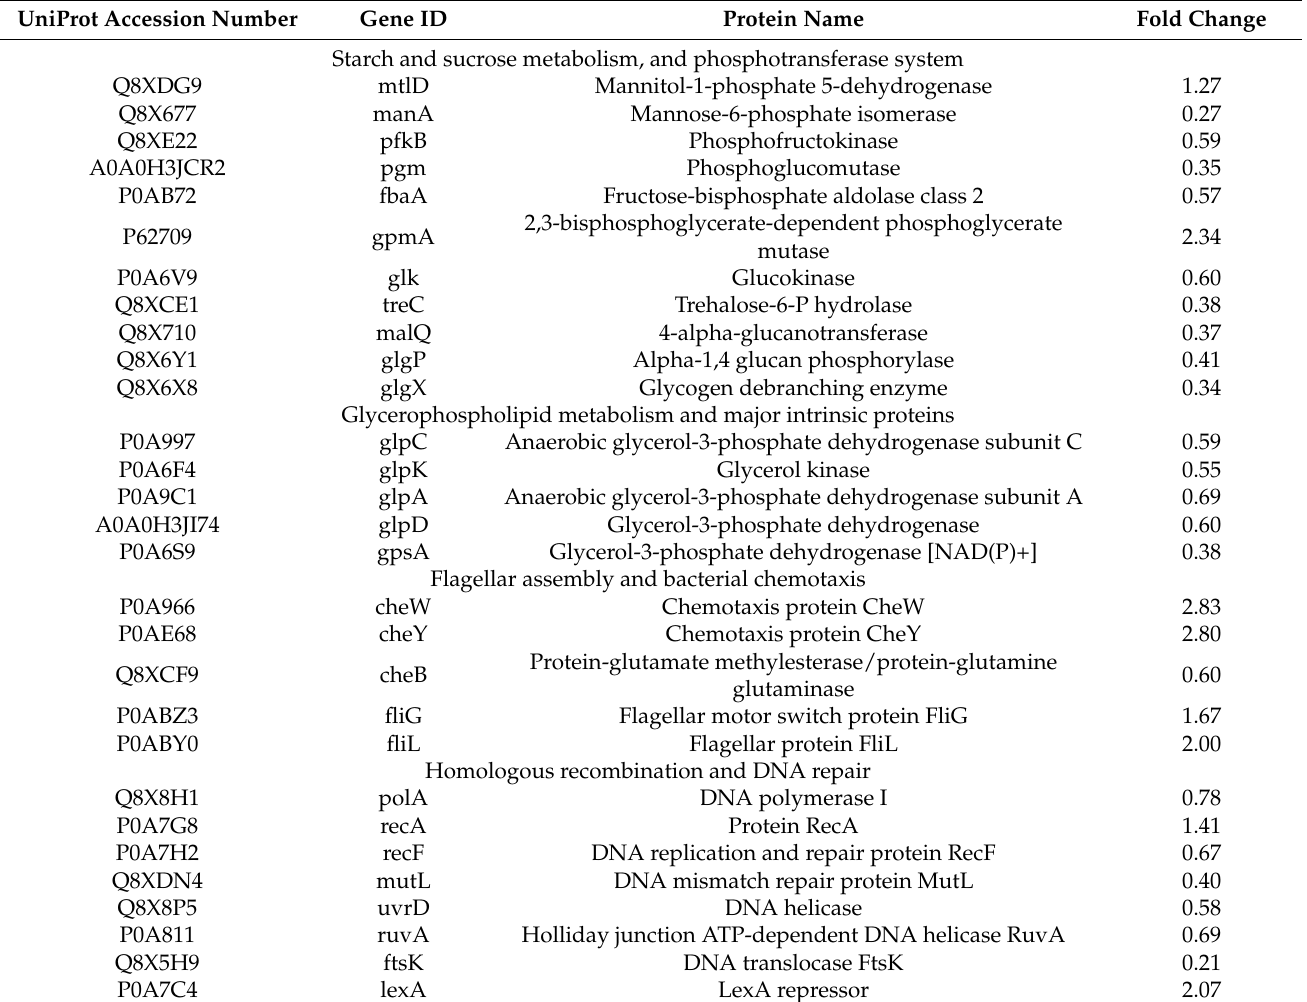
Table 2. Related differentially expressed proteins in network clusters of